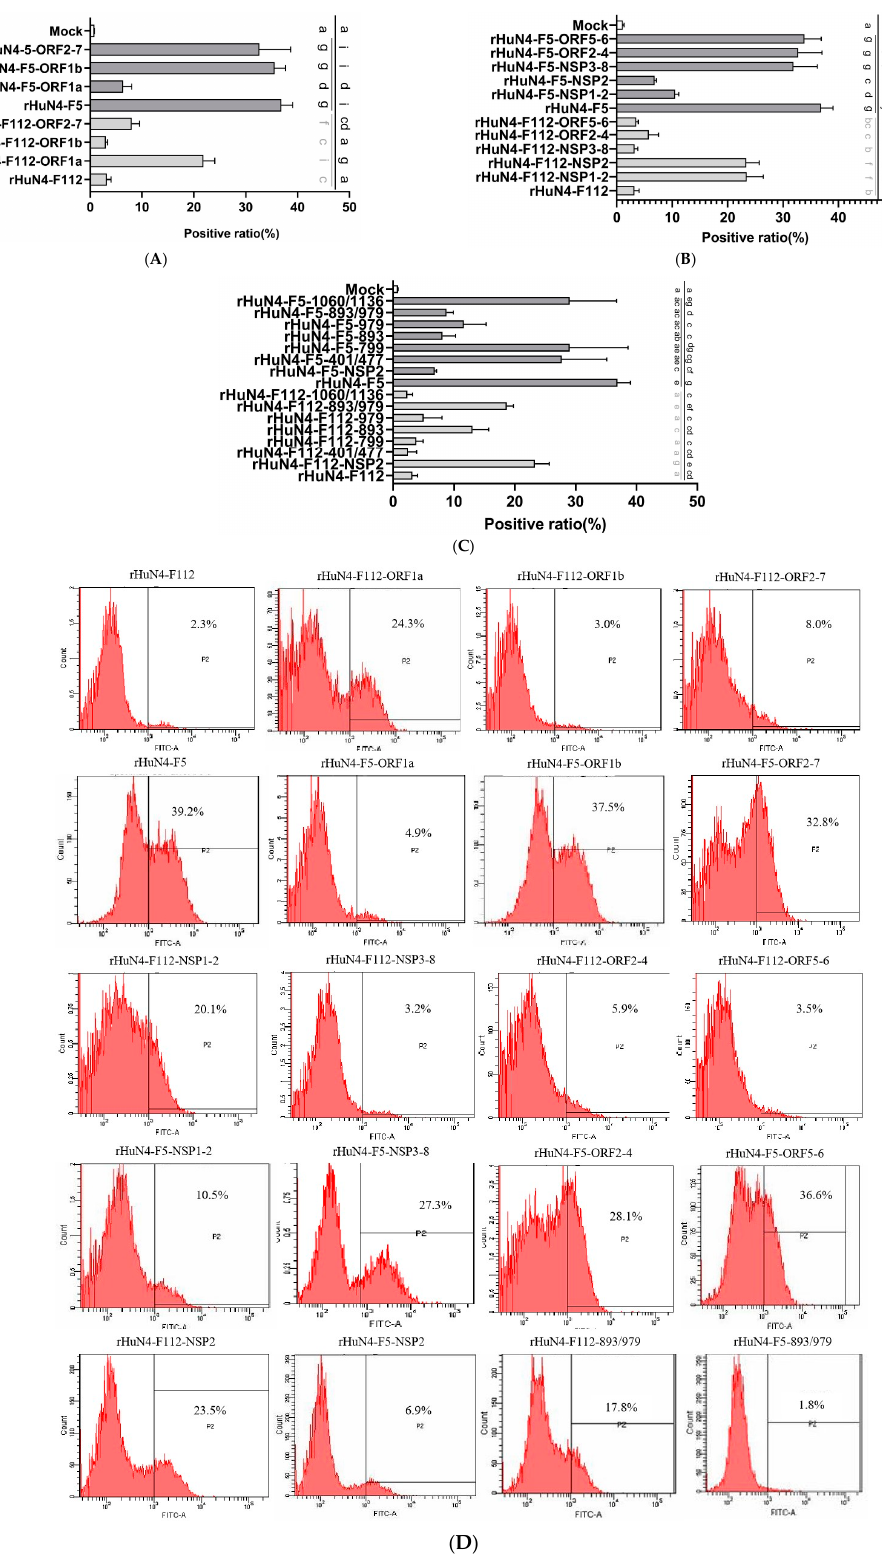
Figure 2. Infection efficiency of the chimeric viruses. ( A ): Infection efficiency of the chimeric viruses with ORF1a, ORF1b and ORF2-7 exchanged. ( B ): Infection efficiency of the chimeric viruses with NSP1-2, NSP2, NSP3-8, ORF2-4 and ORF5-6 exchanged. ( C ): Infection efficiency of the